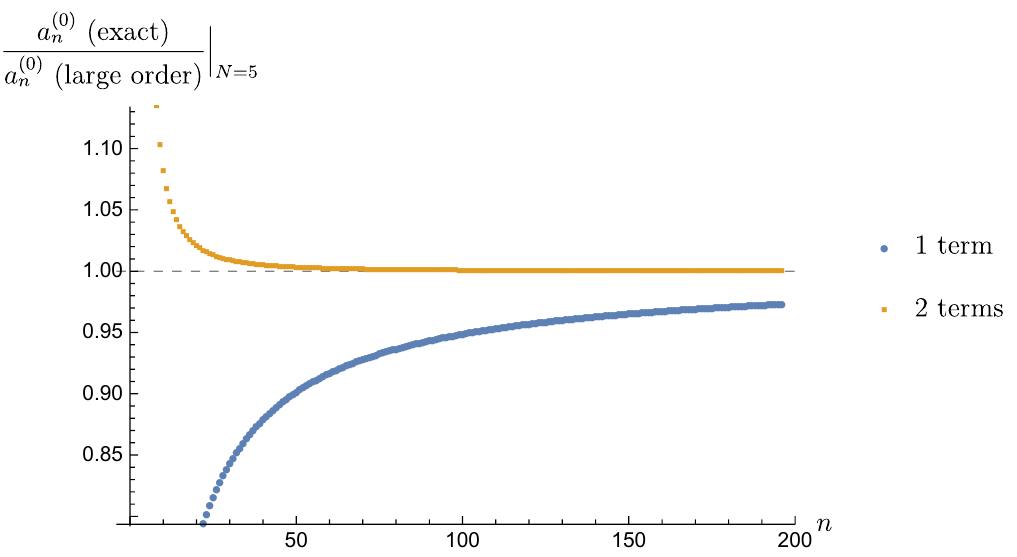
Figure 1 . Ratio of numerically computed large order growth of the perturbative coe(cid:14)cients a (0) n and the series expansion (2.16) with just the (cid:12)rst term (blue circles) and (cid:12)rst two terms (red